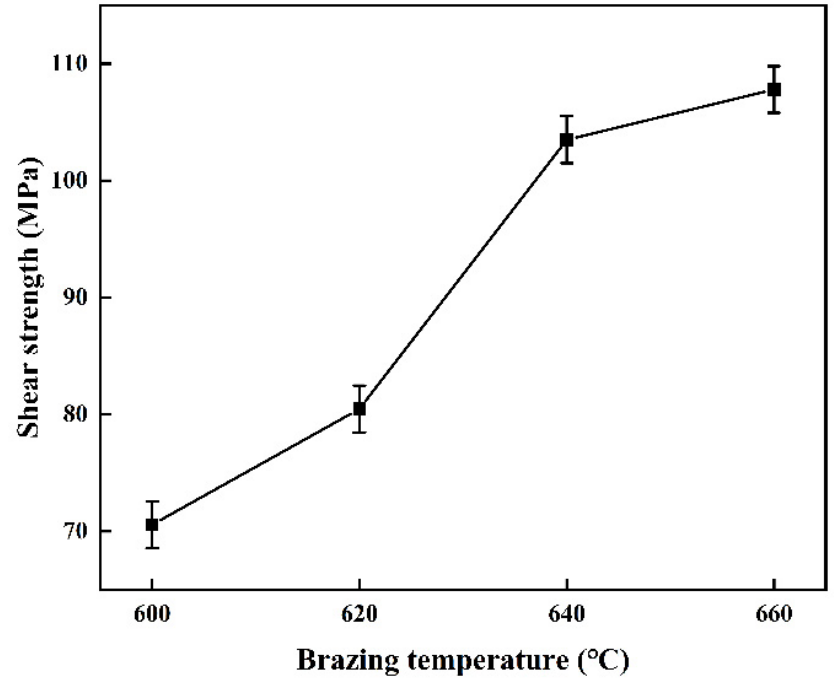
Figure 7. Shear strength of AlN/Al brazed joints. The brazing temperatures of the joints are 600 °C, 620 °C, 640 °C and 660 °C.